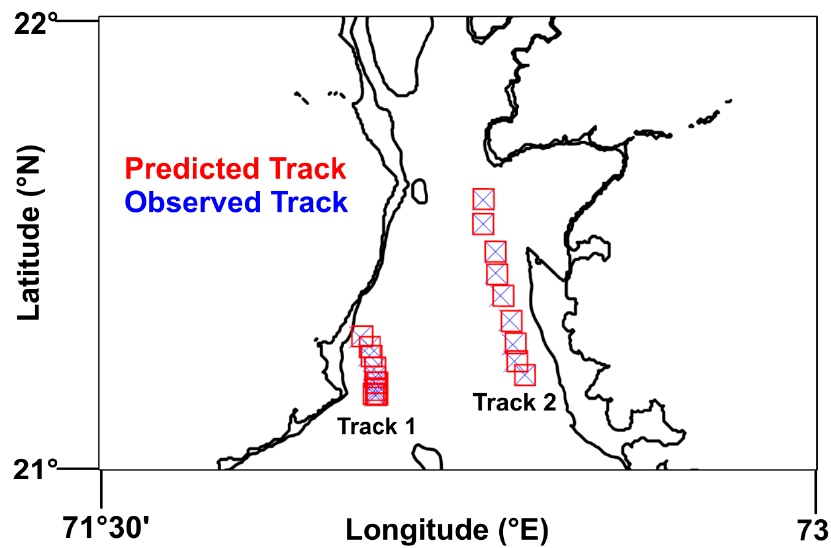
Figure 5. Comparison of observed and predicted Lagrangian particle track; Track 1 represents ebb condition, while Track 2 represents flood condition. Table 1. Details of data used for calibration of tide and current.